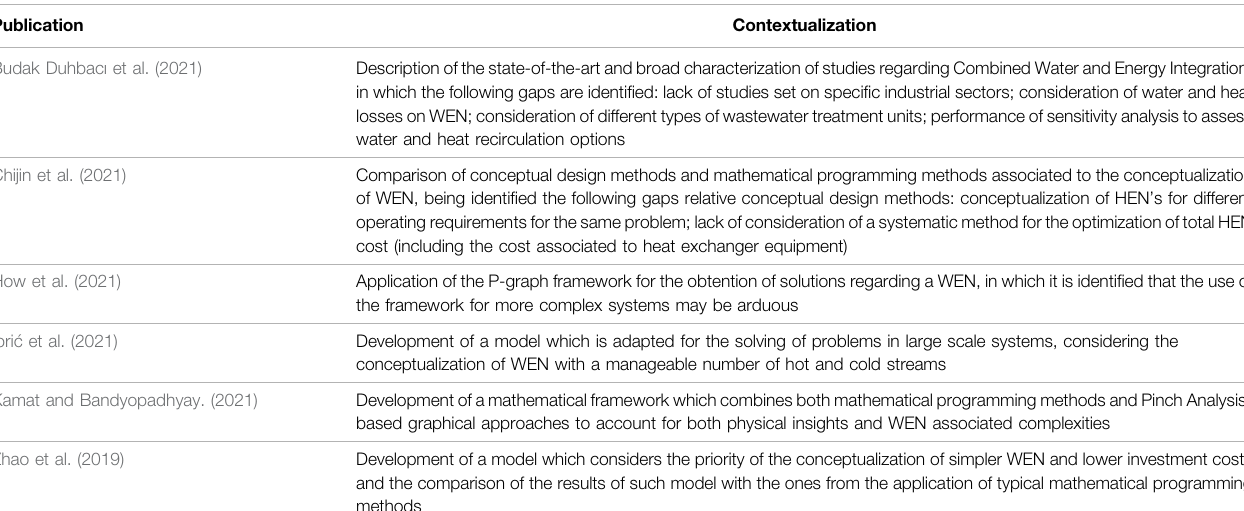
TABLE 2 | Contextualization of recent studies regard Combined Water and Energy Integration.